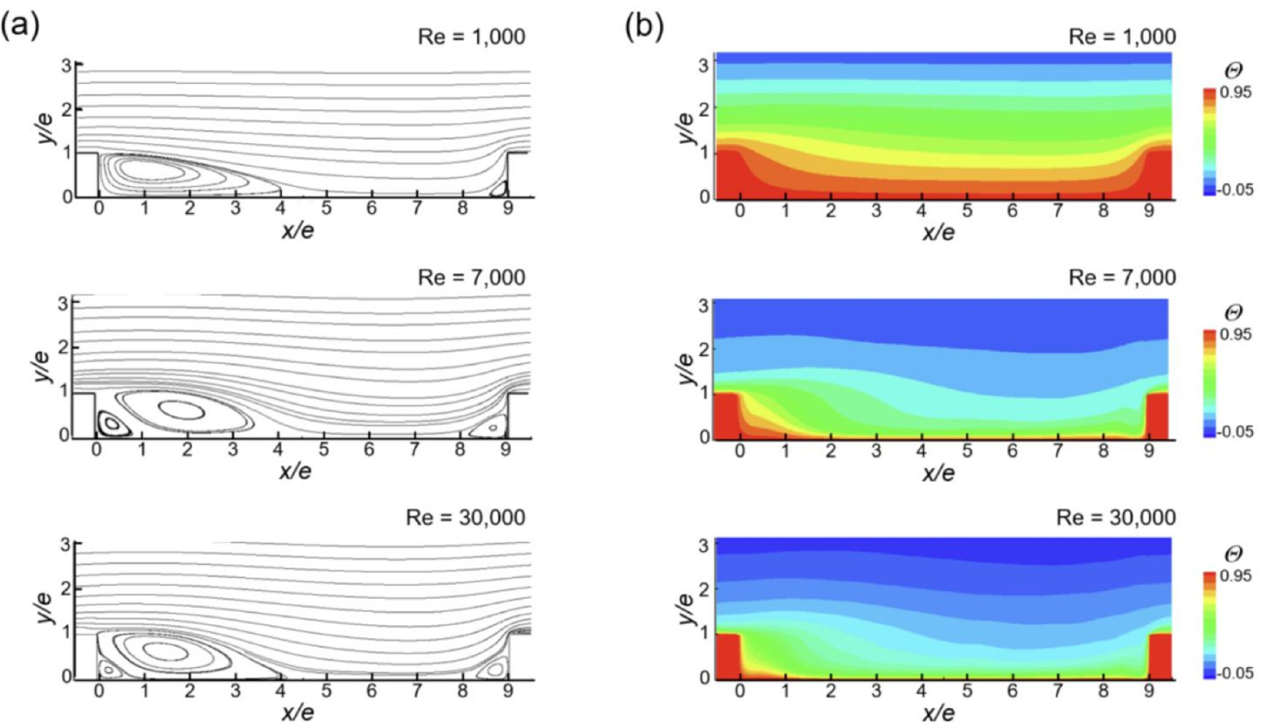
Figure 3. Time-averaged flow and temperature fields on the isothermal walls for each Reynolds number; ( a ) time-averaged streamlines; ( b ) time-averaged temperature field.